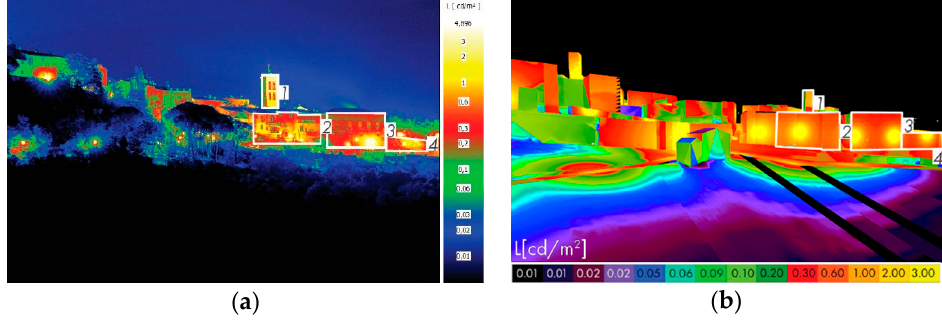
Figure 7. Comparison of the measured and simulated average luminance values from the external viewpoint E1 . ( a ) Measured luminance distribution; ( b ) simulation output. Table 3. Comparison of the measured and simulated average luminance values from the external viewpoint E1 . (1) Bell tower (2) residential building (3) residential building (4) Historic wall.